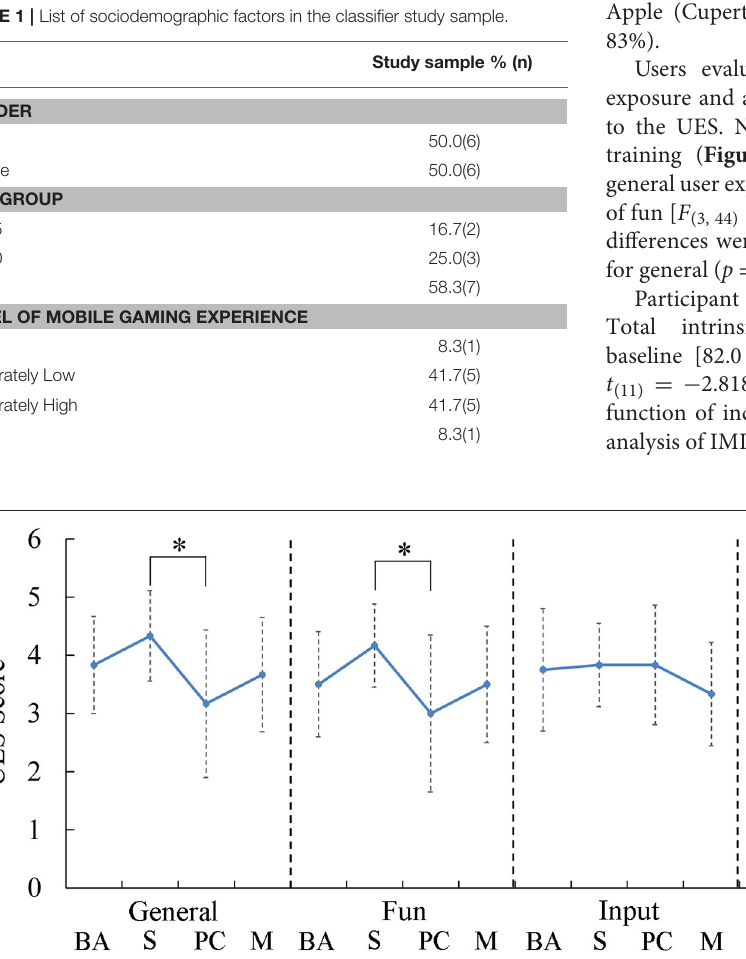
Frontiers in Bioengineering and Biotechnology |